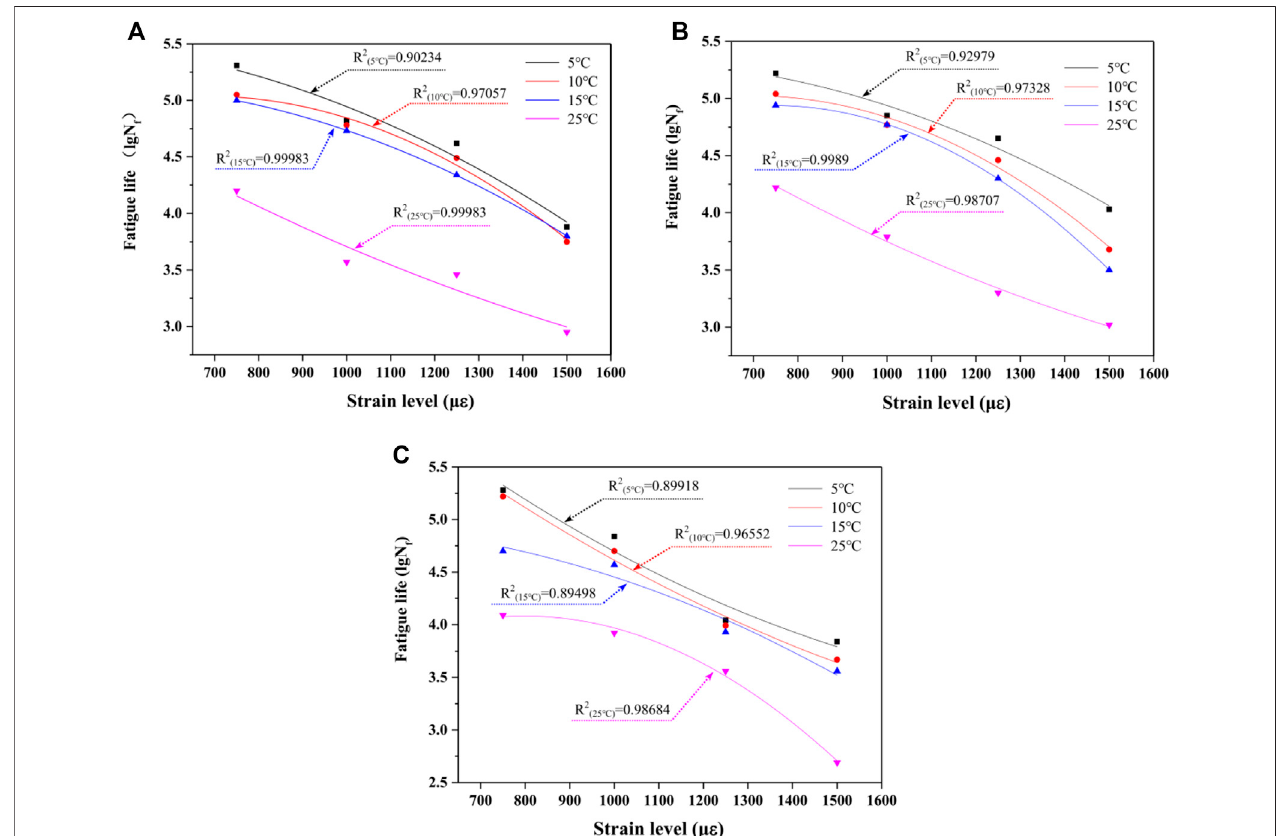
FIGURE 6 | Effect of strain on the fatigue life: (A) 2 Hz; (B) 10 Hz; (C) 15 Hz.